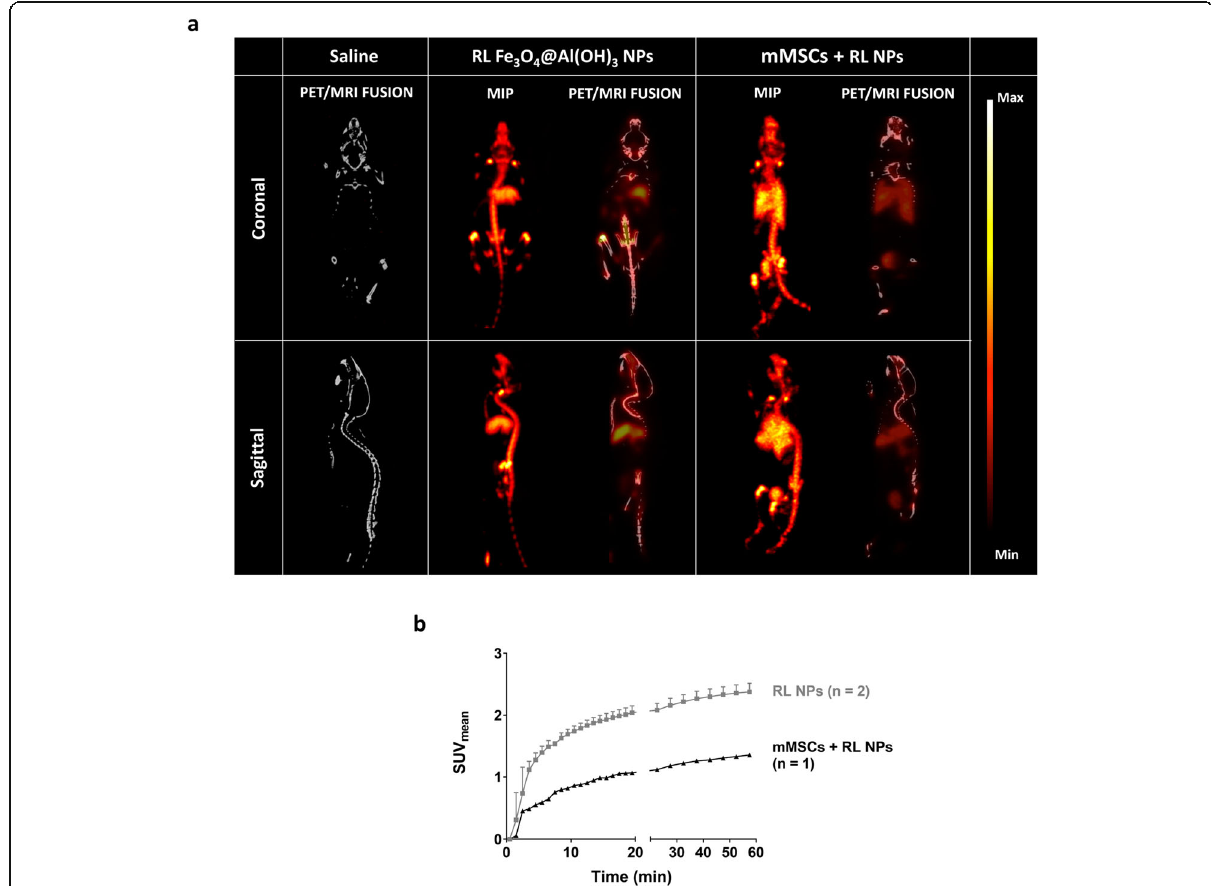
Fig. 5 Bone uptake after injection of 18 F-labeled Fe 3 O 4 @Al(OH) 3 NPs or mMSCs labeled with these NPs. After acquisition of the last PET/MRI scan, a CT scan was acquired for a subgroup of mice to visualize the bone structure. a After injection of either RL NPs or mMSCs labeled with RL NPs (mMSCs + RL NPs), 18 F uptake was visualized in the bones of the mice on the maximum intensity projection (MIP) images and overlays of CT- based bone mask and 1 h static 18 F-PET (SUV = 0 – 9). b Corresponding quantification (mean standardized uptake values, SUV mean ) confirms the gradual uptake in bone. Significant differences were found between both groups starting from 4 min post injection (PI) of the tracer (frame 5) based on a repeated measures two-way ANOVA with Bonferroni correction for multiple comparisons (4 min PI: p < 0.05, 5 – 11 min PI: p < 0.01, from 12 min PI on: p <